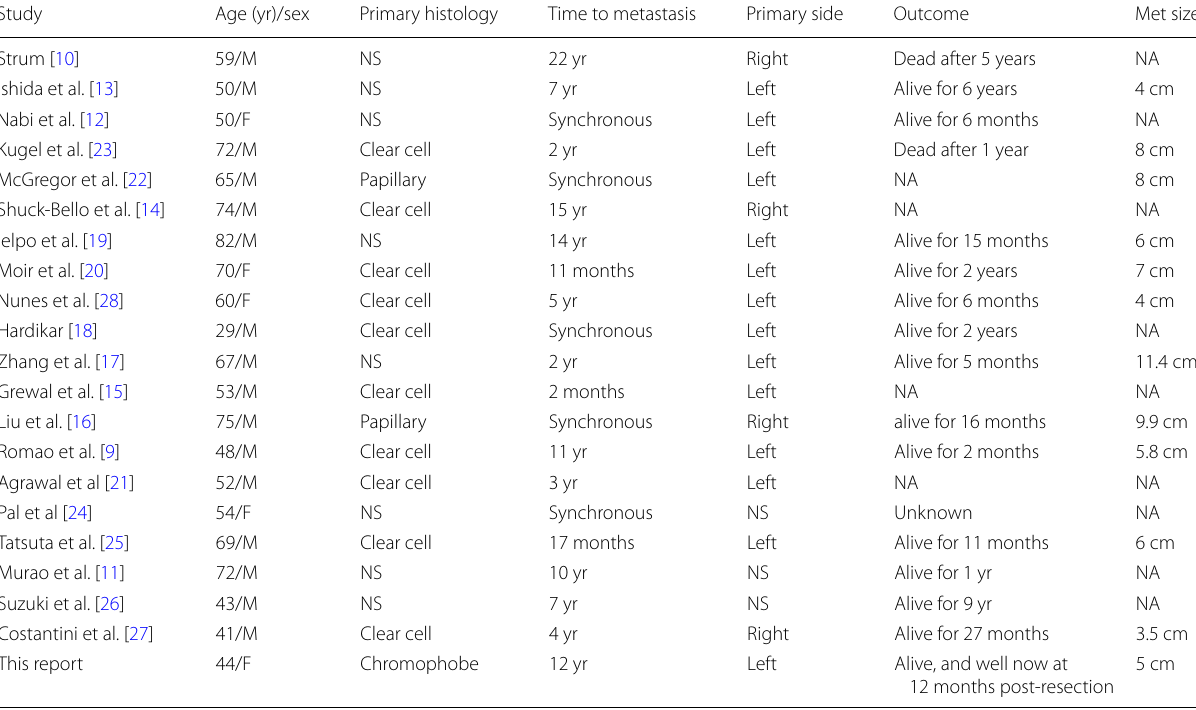
NS not specified, NA not